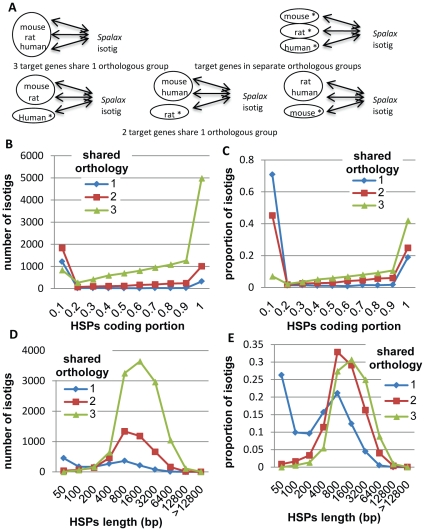
Shared orthology categories.(a) Category-3: Three target genes share one orthologous group (upper left). Category-2: Two target genes share one orthologous group (below). Category-1: the target genes are mapped to separate orthologous groups (upper right). Asterisk, near species name, indicates that the target gene is mapped to separate orthologous group, or that no hit was found. (b) The number of isotigs in each category (i.e., 1, 2, and 3) as a function of the HSP coding portion, measured as the total isotig size mapped to target coding region divided by the size mapped to both the coding and untranslated regions; (c) The proportion of isotigs in each category as a function of the HSP coding portion. (d) The number of isotigs in each category as a function of the total length mapped to target transcript. (e) The proportion of isotigs in each category as a function of the total length mapped to target transcript.